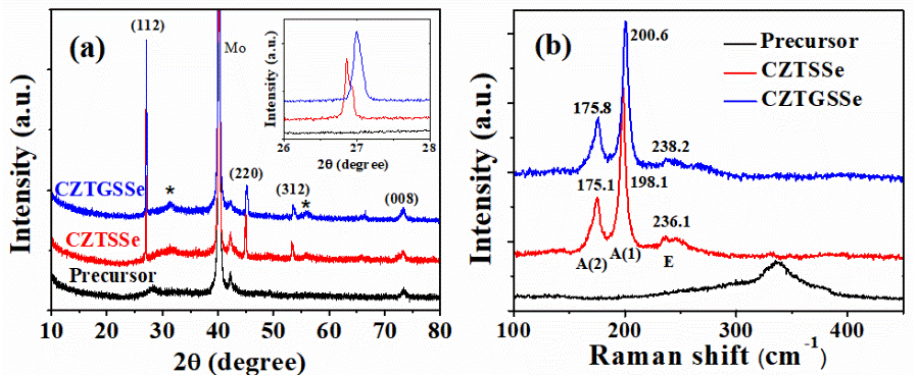
Figure 3. ( a ) XRD patterns and ( b ) Raman spectra of the precursor, CZTSSe, and CZTGSSe films.